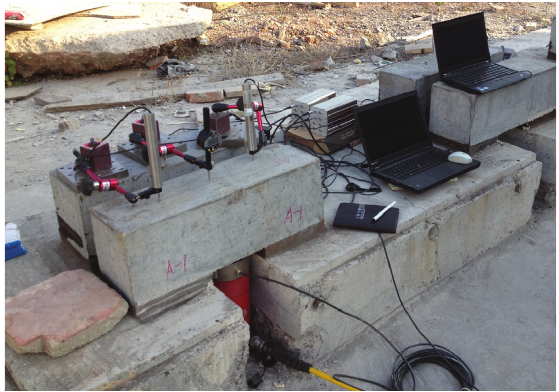
Figure 6: Setup of the scale central-loading vertical push plate